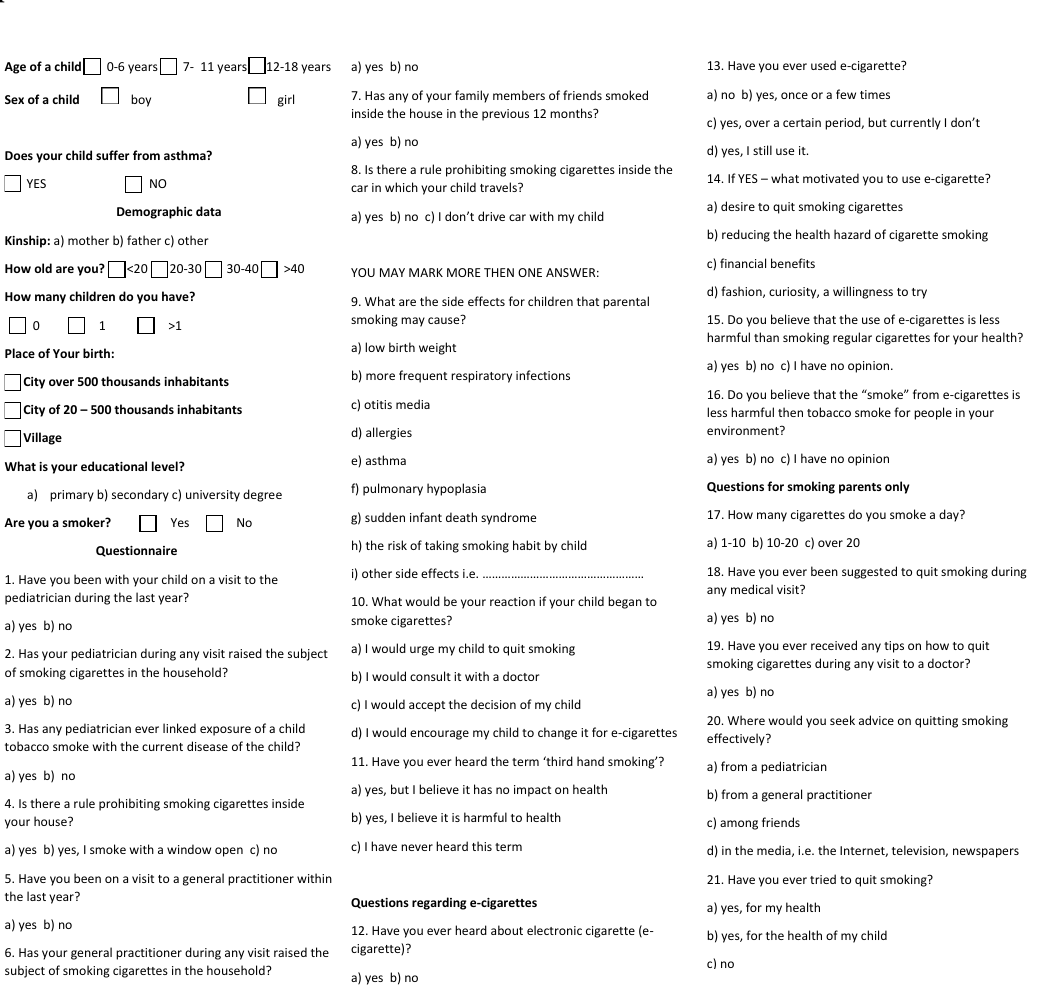
Figure A1. Questionnaire for parents regarding cigarette smoking and SHS exposure among their children.